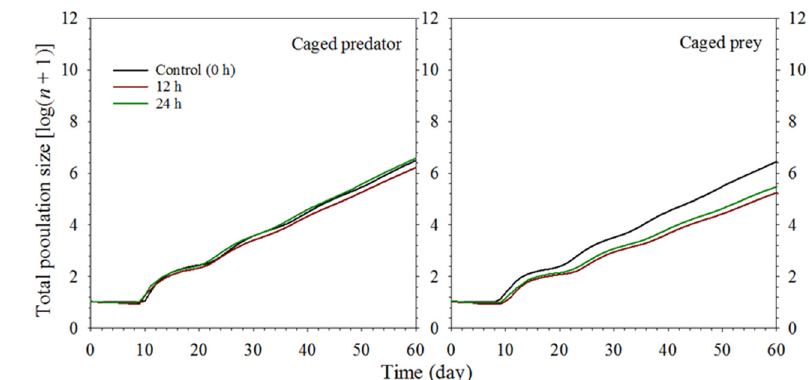
Figure 6. Population projections for Sitobion miscanthi reared under predator Coccinella septempunctata risk at different exposure times (0, 12, and 24 h) with either the caged predator or caged prey treatments.